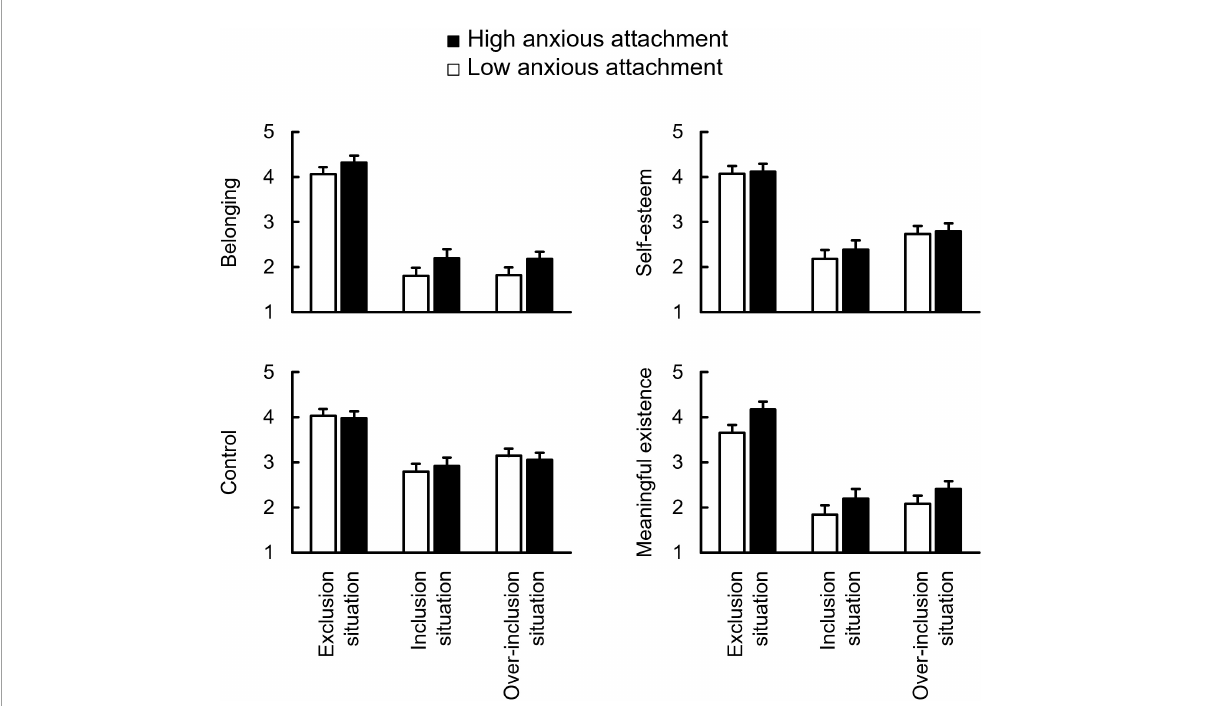
FIGURE1 Comparison between low and high anxious attachment of need-threat score for belonging, self-esteem, control, and meaningful existence in three situations. Error bars indicate the standard error of means across